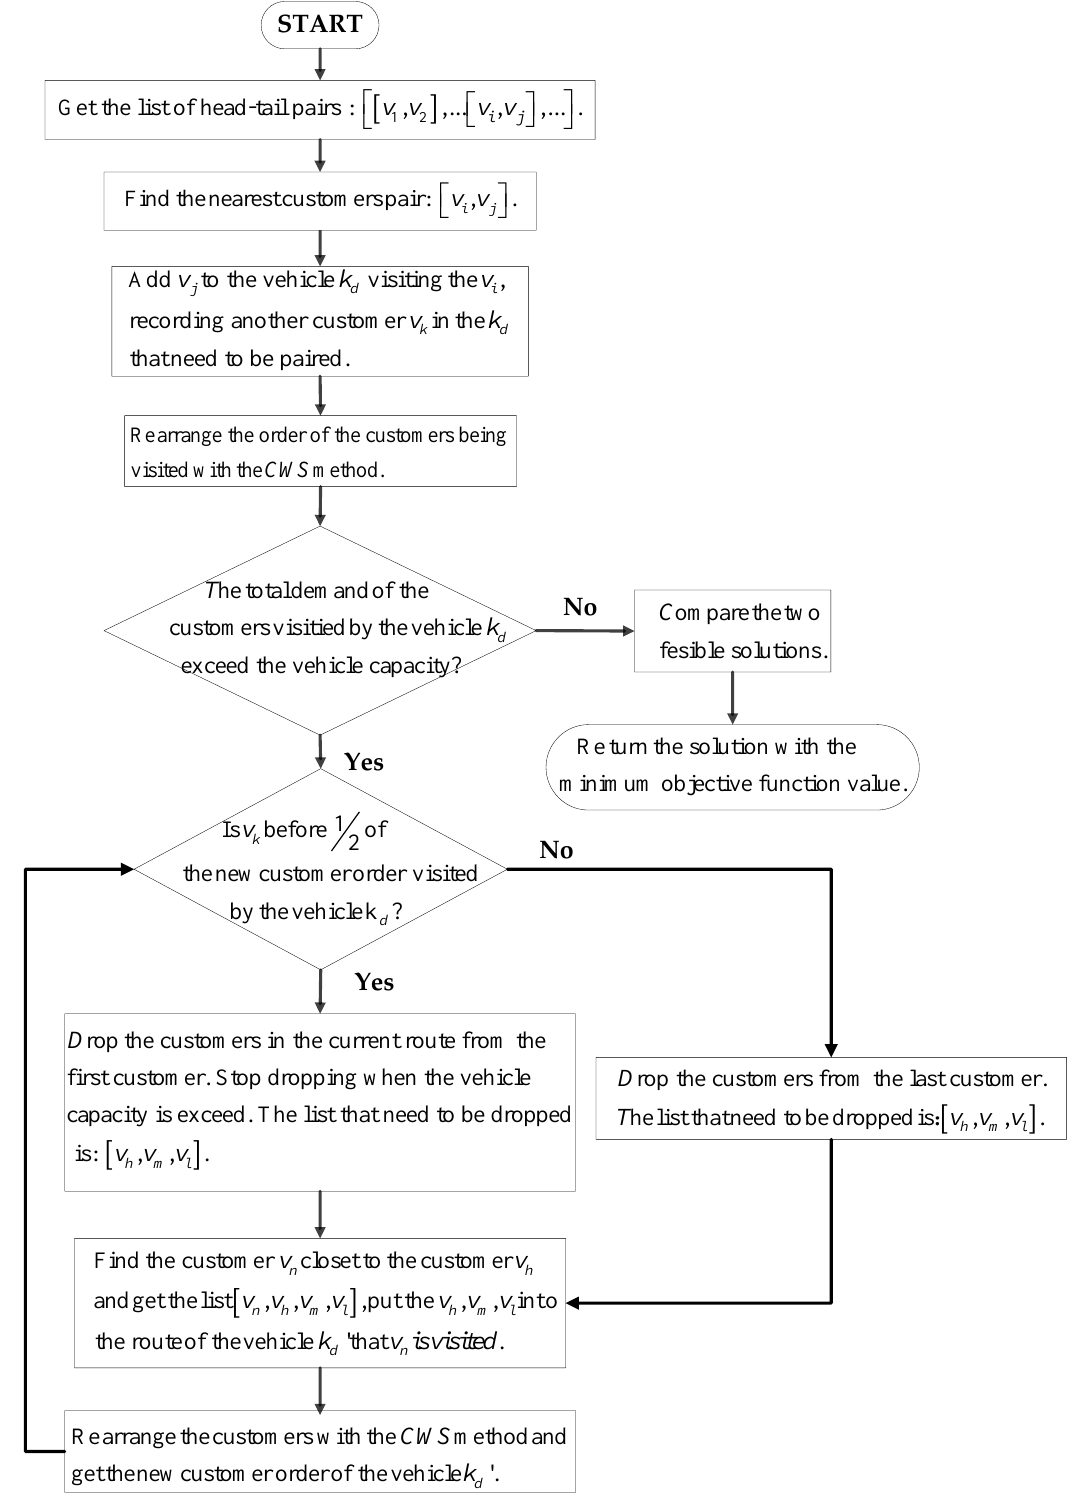
Figure 7. The flowchart of the MHDT strategy.